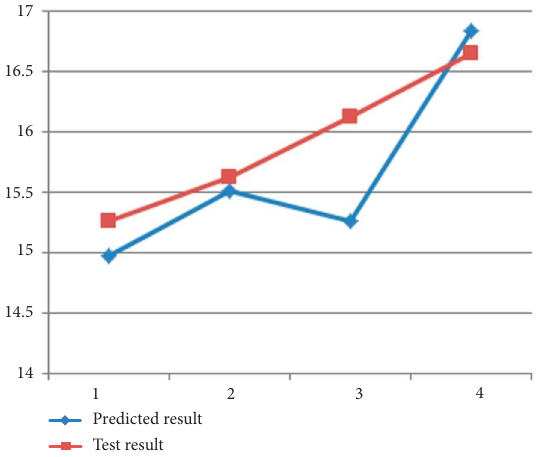
Figure 23: Volumetric shrinkage fit comparison.